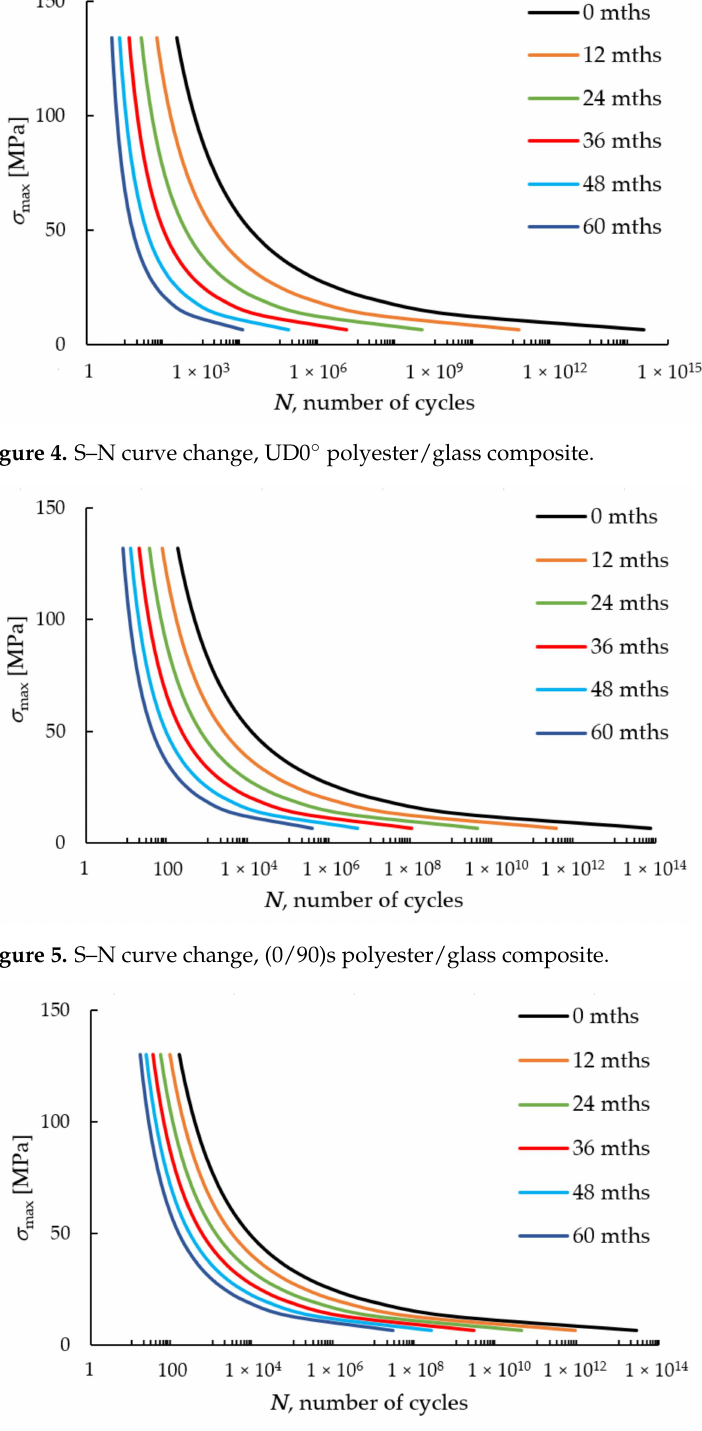
Figure 6. S–N curve change, (0/45/90)s polyester/glass